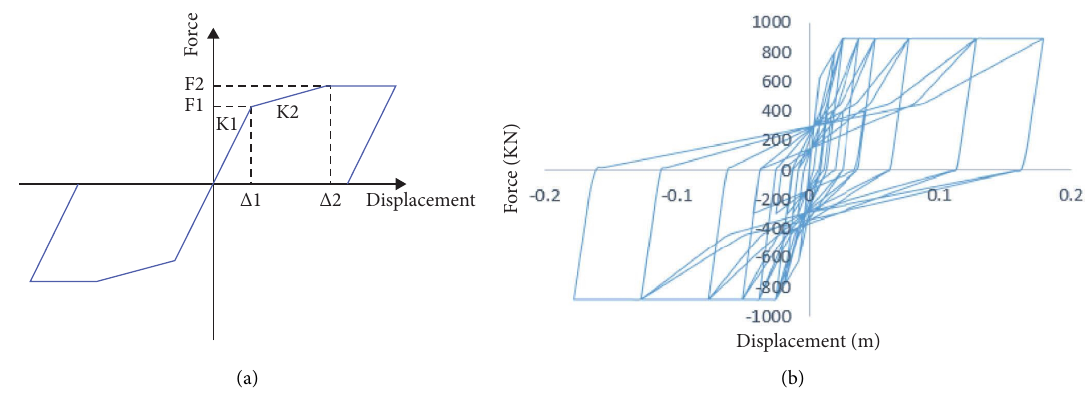
Figure 8: (a) Backbone curve [60] and (b) cyclic behavior of abutment